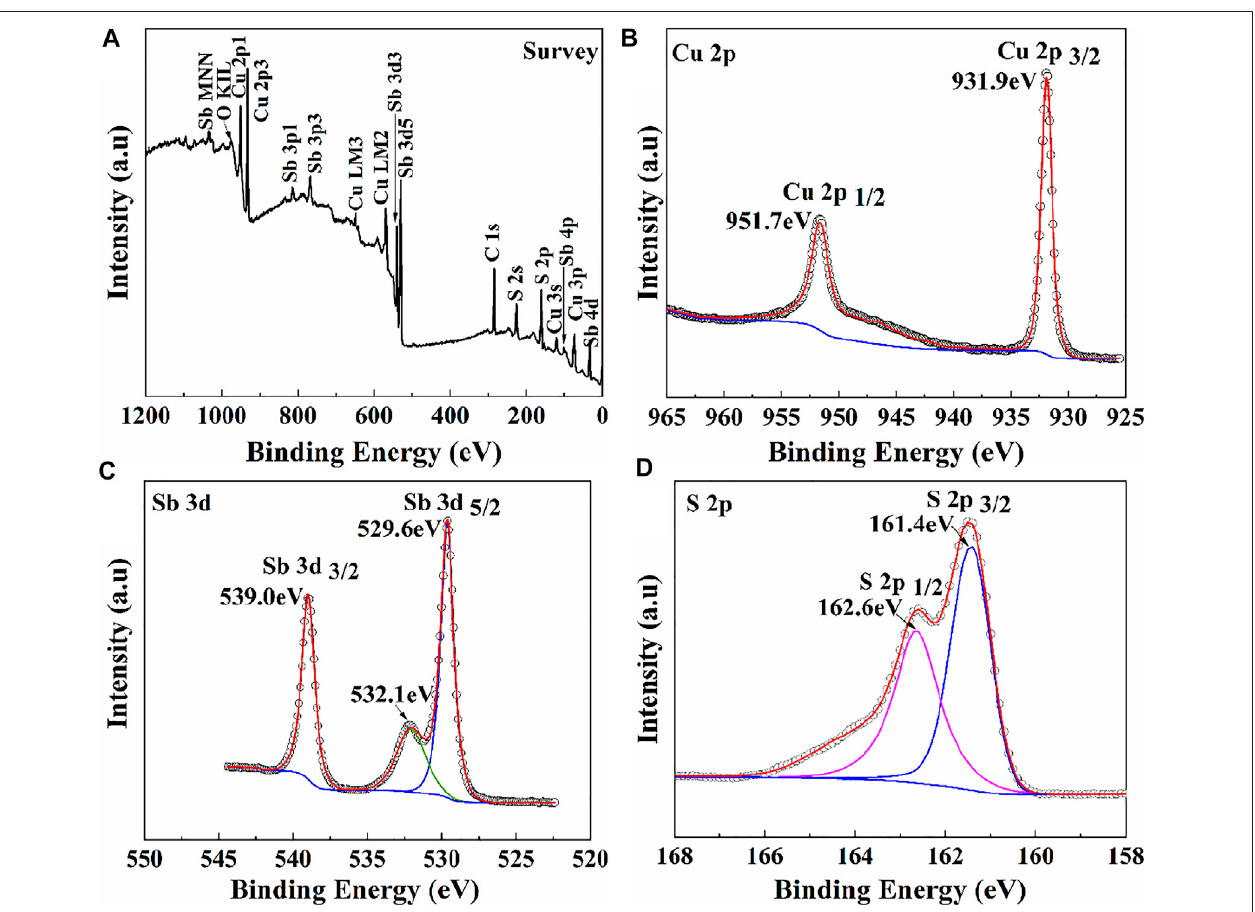
FIGURE 8 | XPS of the CuSbS 2 thin fi lms prepared at 360 ° C. (A) Survey, (B) Cu 2p core level, (C) Sb 3 days core level, and (D) S 2p core level.